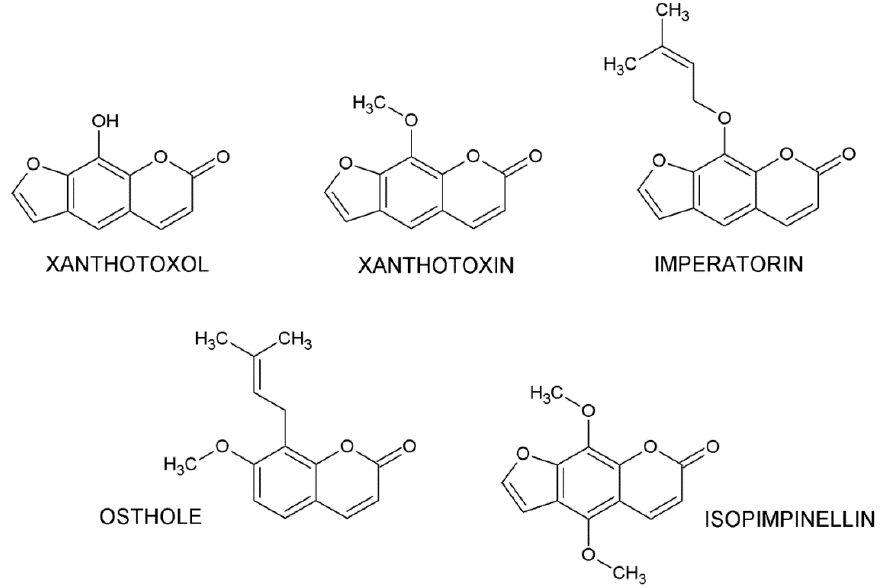
Figure 1. Chemical structure of selected coumarins.